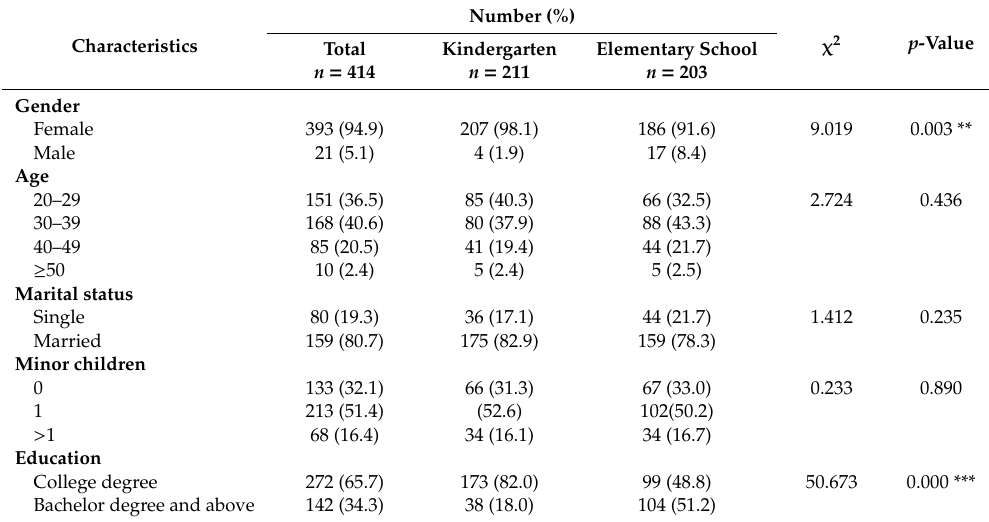
Table 1. Distribution of the background characteristics of participants.